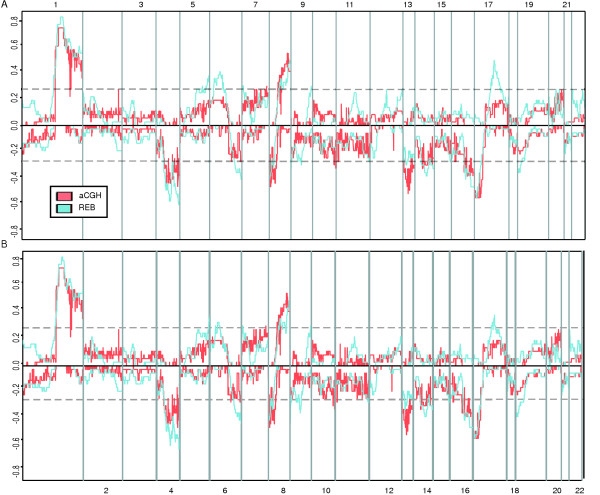
Summary of REBs and DNA copy number changes in HCC. A summary of the data generated as described in Figure 2. A. For each genetic loci on the autosomal chromosomes, the fraction of HCC samples that contained significant upwards expression biases were plotted as a positive fraction and the fraction of samples that contained significant downwards expression bias were plotted as a negative fraction. DNA copy number data determined by aCGH was plotted in a similar manner. B. Data was plotted as in A., with the exception that genes involved in cell proliferation and nucleic acid metabolism were removed, as described in the text, before REBs were identified.